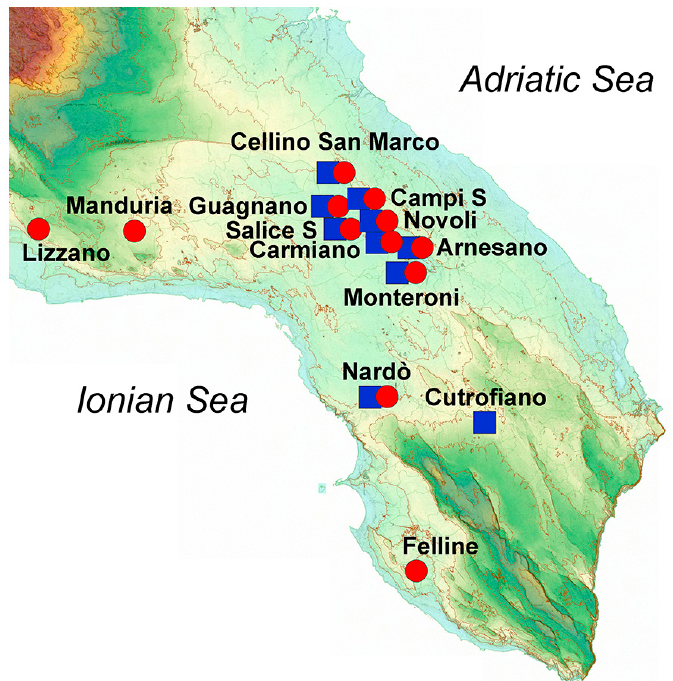
Figure 1. Image representing the orographic features of Salento and the sites of production of the wines studied. Red circles represent Negroamaro wines, and blue squares represent Primitivo wines.